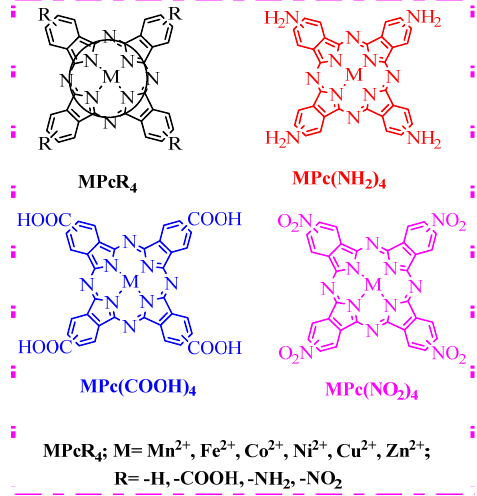
Figure 2. The structure of metal phthalocyanine.